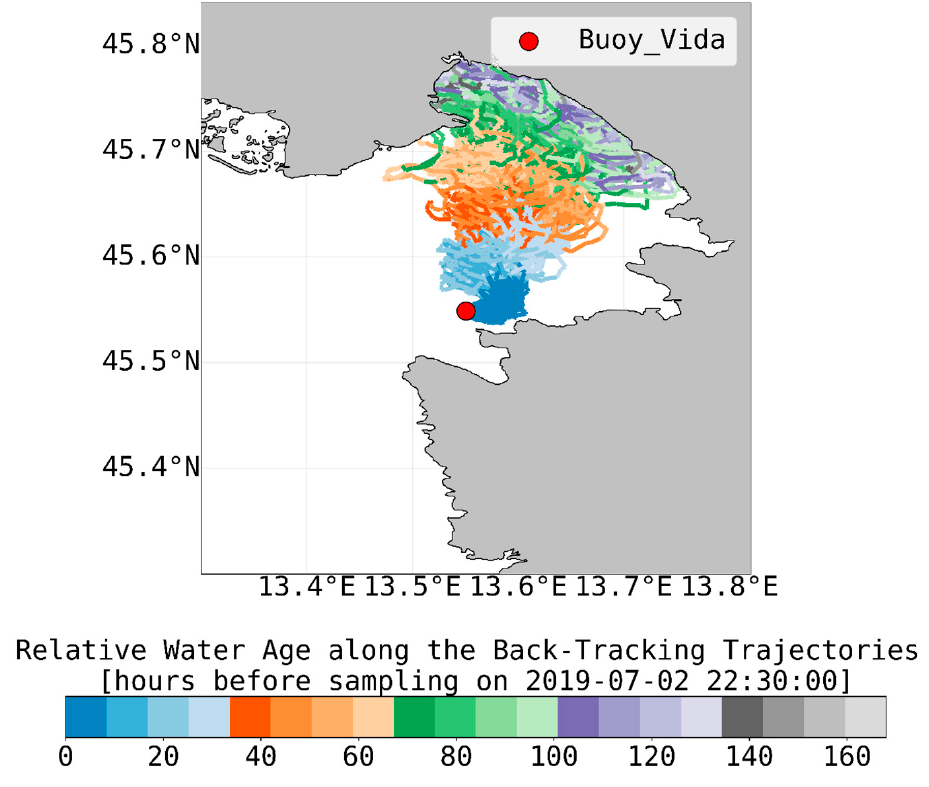
Figure 6. Trajectories (back-propagation) of water particles prior to reaching the buoy Vida location on 2 July at 22:30 UTC, color-coded by the relative water age.